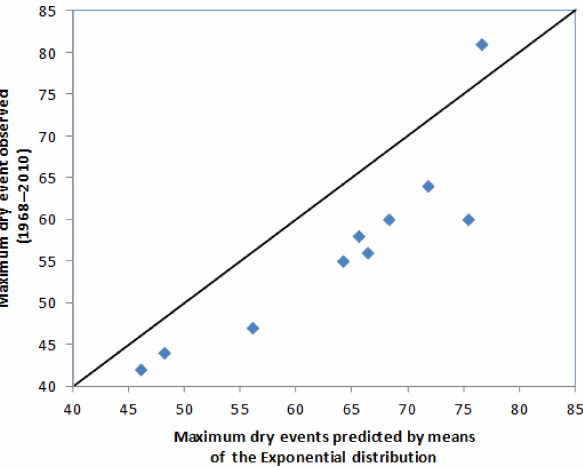
Figure 5. Differences between maximum dry events observed and estimated using PDS modelled using the Exponential